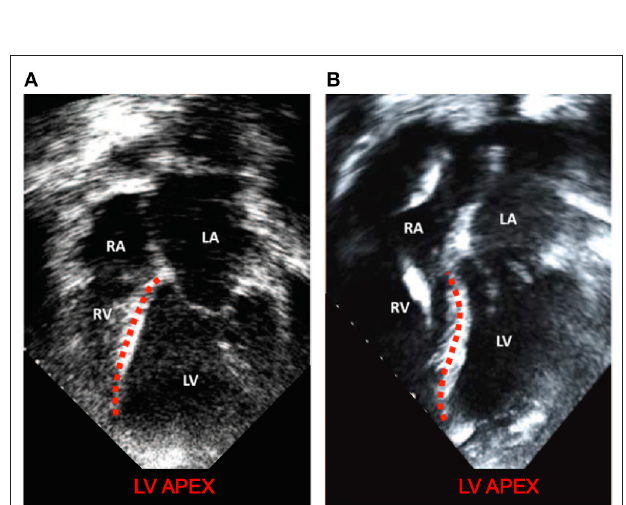
FIGURE 9 | Modified with permission from Topilsky et al. (2011). (A) a patient with low RPMs and normal, right shifted interventricular septum (traced out by the red line) compared to (B) a patient with markedly left-shifted septum (traced out by the red line). LV, left ventricle; RV, right ventricle; LA, left atrium; RA: right